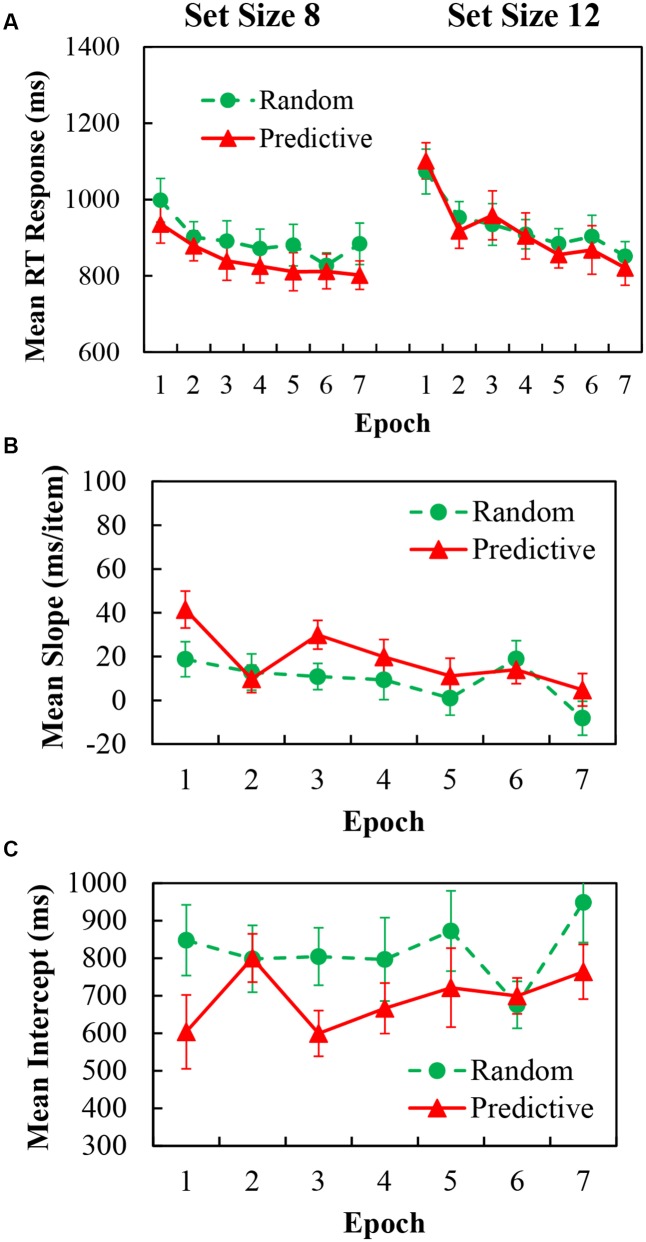
(A) Mean correct RTs in each epoch for predictive (red) and random (green) configurations in set size 8 (Left) and set size 12 (Right) of Experiment 2. (B) Search slopes (ms/item) for predictive (red) and random (green) configurations over epoch of Experiment 2. (C) Intercepts (ms) for predictive (red) and random (green) configurations over epoch of Experiment 2.